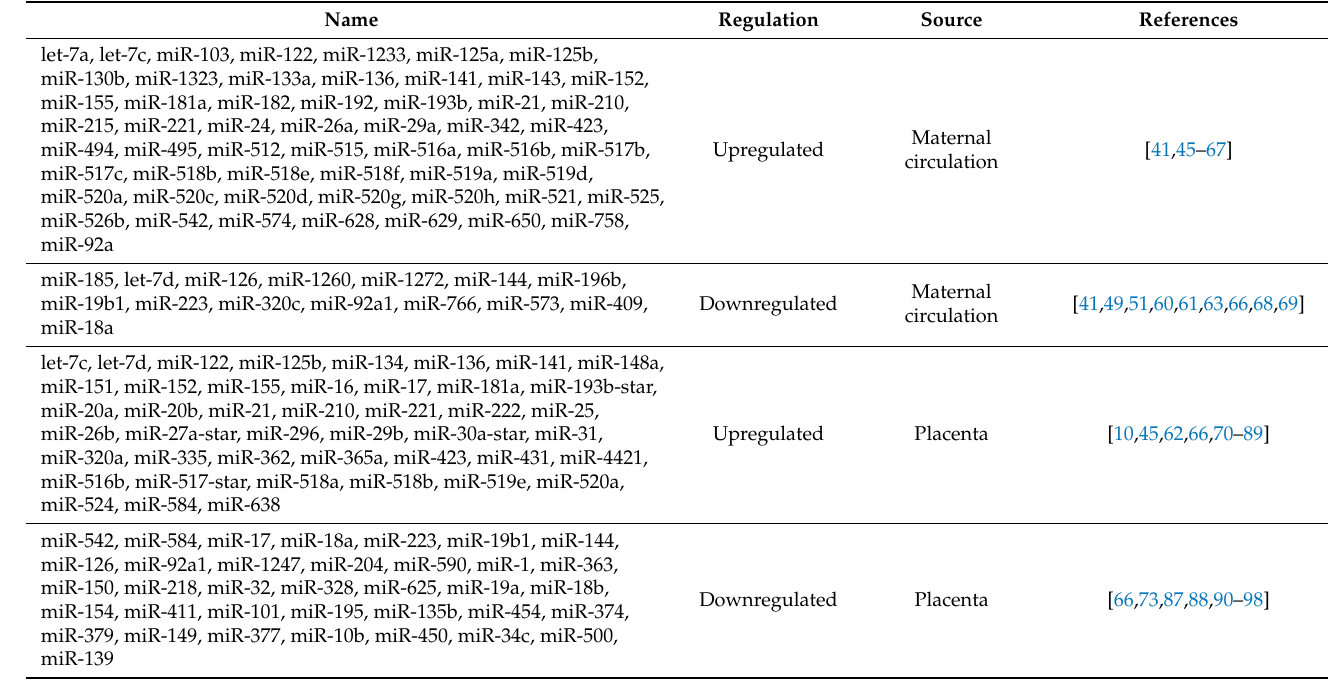
Table 1. Overview of miRNAs in preeclampsia (PE).